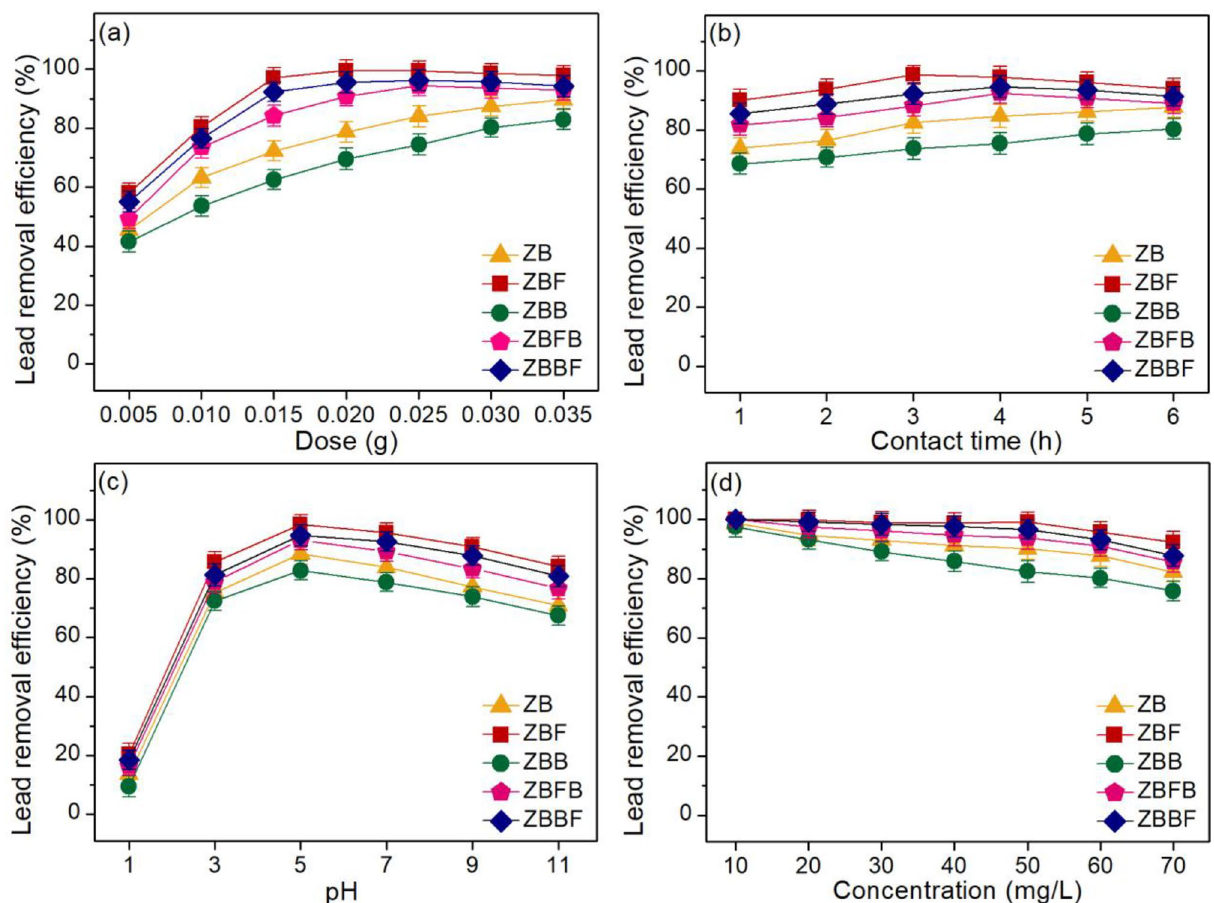
Figure 7. Lead absorption efficiencies of zeolite A sugarcane bagasse fly ash powder (ZB), zeolite A sugarcane bagasse fly ash powder mixed iron(III) oxide-hydroxide (ZBF), zeolite A sugarcane bagasse fly ash beads (ZBB), zeolite A sugarcane bagasse fly ash powder mixed iron(III) oxide-hydroxide beads (ZBFB), and zeolite A sugarcane bagasse fly ash beads coated iron(III) oxide-hydroxide (ZBBF) investigated by ( a ) dosage, ( b ) contact time, ( c ) pH, and ( d ) initial lead